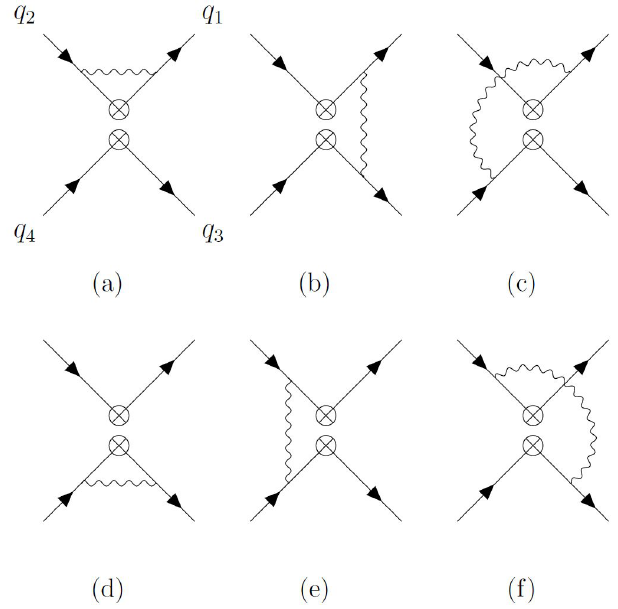
Figure 2. One-loop QED vertex corrections to four-quark